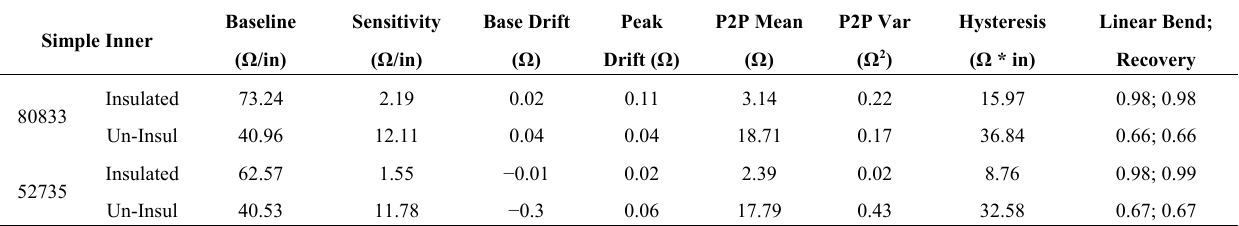
Table 2. Simple inner bend parameters for stiffest (80833) and least stiff (52735) fabric, both in the insulated and un-insulated sensor cases.